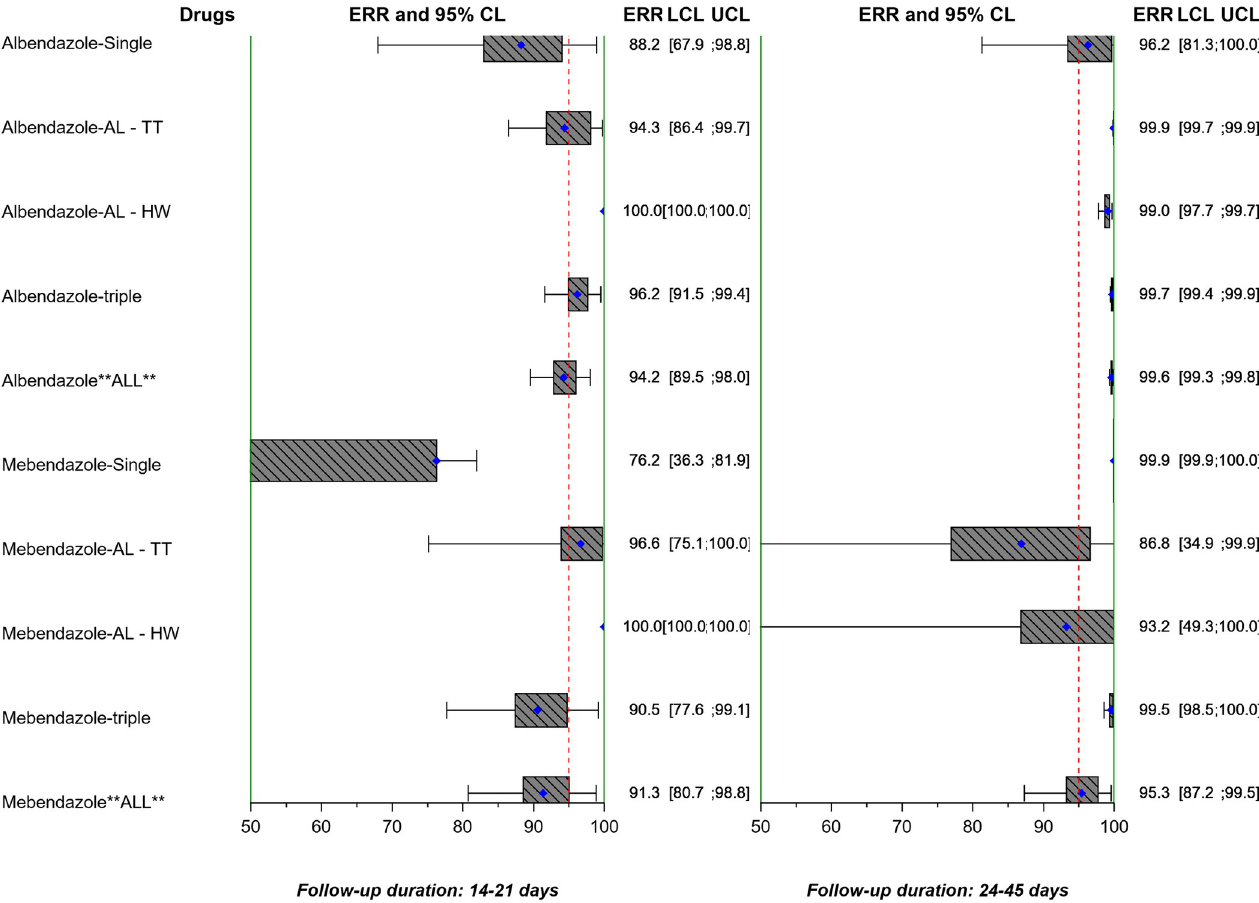
Fig 6. Forest plot of geometric mean ERR of T . trichiura by study. The vertical lines correspond to the WHO minimal criteria for efficacy [8] by species, as well as drug in the case of albendazole ( A . lumbricoides > 95%, T . trichiura > 50%, and hookworm > 90%), and mebendazole ( A . lumbricoides > 95%, T . trichiura > 50%, and hookworm > 70%). ERR: egg reduction rate; CL: confidence limits; LCL: lower confidence limit; UCL: upper confidence limit; AL: A . lumbricoides ; TT: T . trichiura ; HW: hookworm.